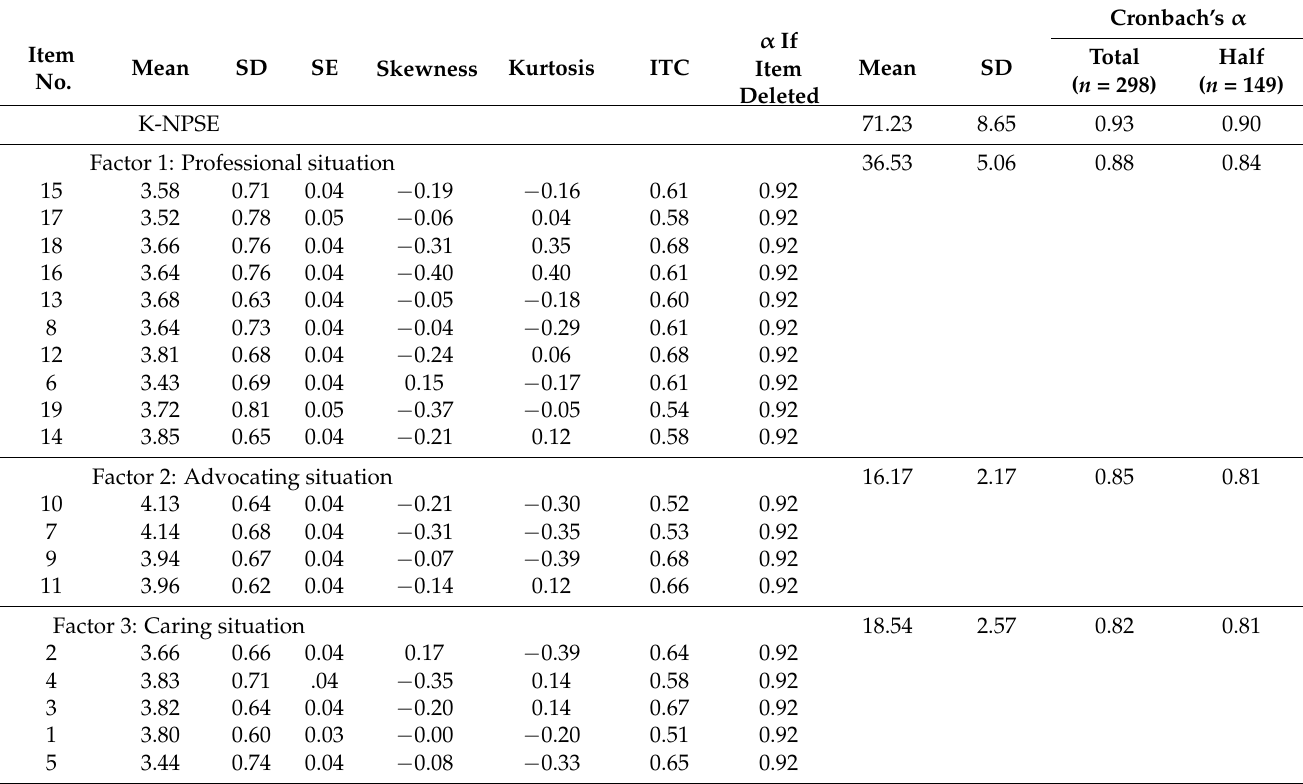
Table 4. Item Analysis and Reliability of K-NPSE (N =